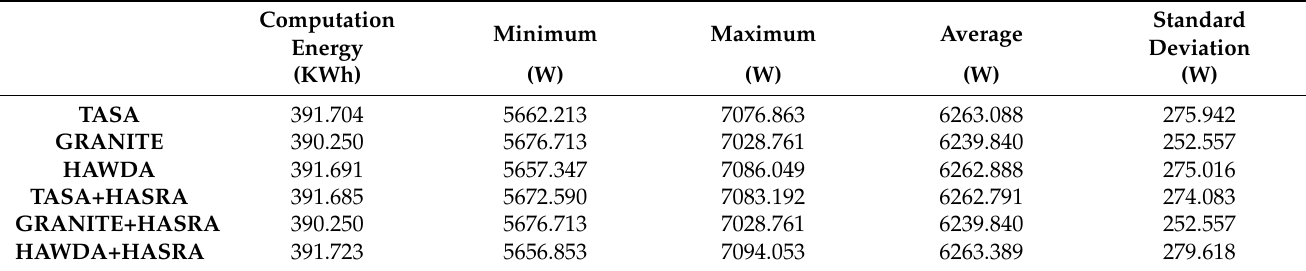
Table 6. Computing energy consumed for 25 h workload execution.